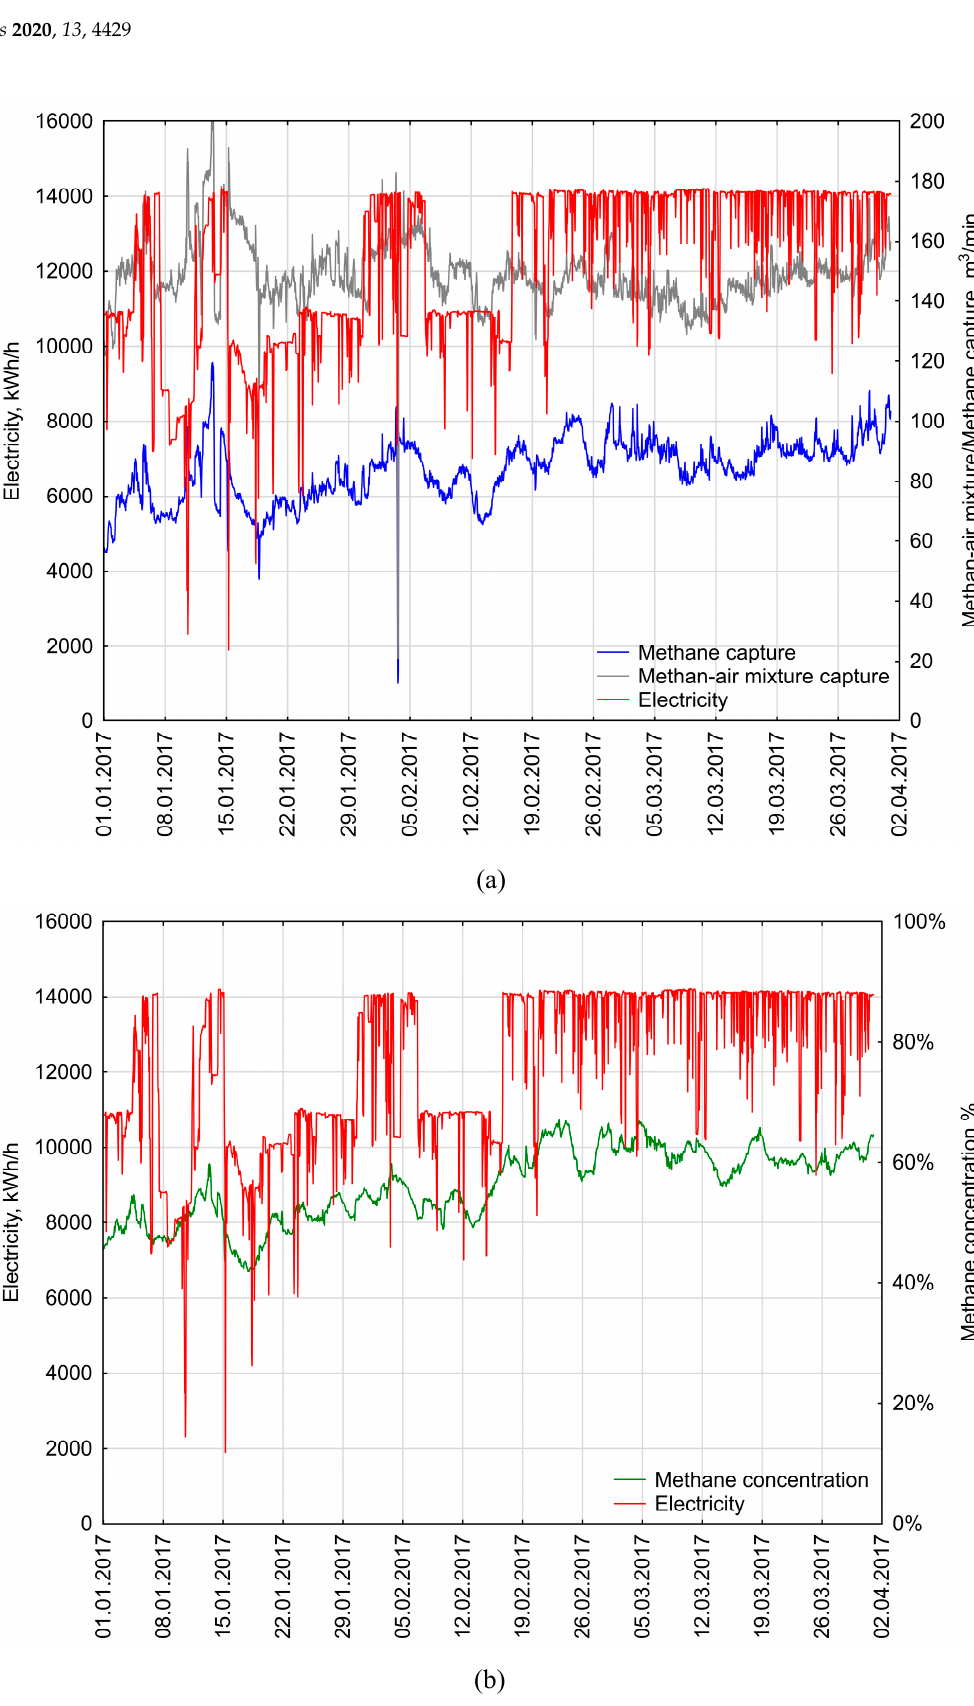
Figure 9. The course of variables in the analysed period. ( a ) Electricity production, clean methane, and methane–air mixture capture; ( b ) electricity production and methane concentration in the